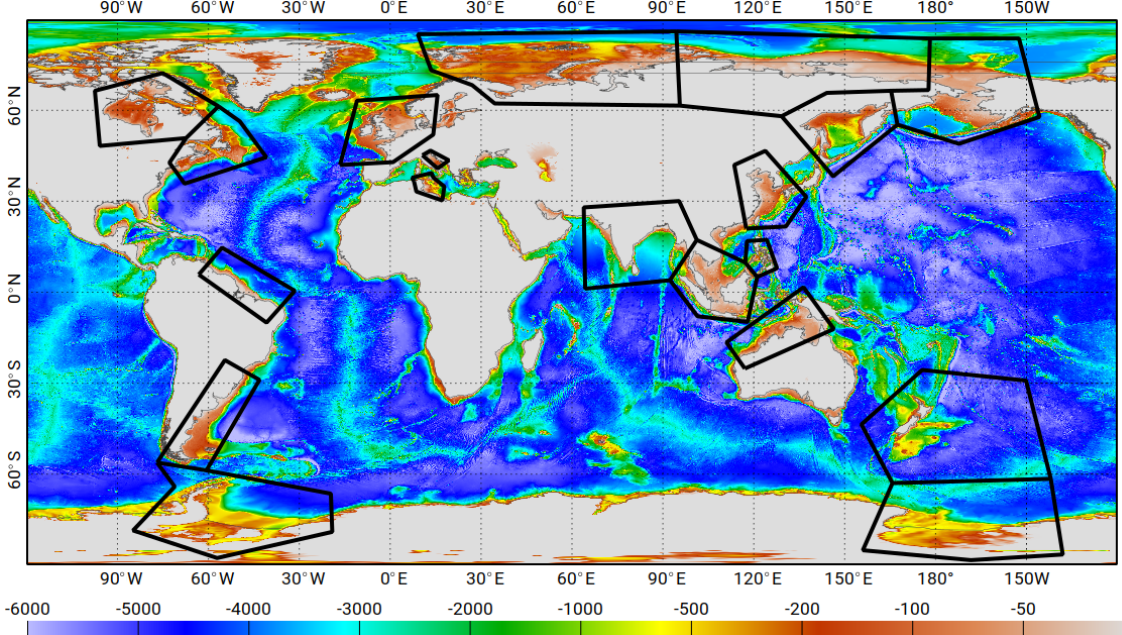
Figure 8. Bathymetry (in metres) used as input in the FES2014 hydrodynamic simulation and polygons where the bathymetry perturbations were implemented for the bathymetry ensemble (note that the members related to the perturbation of bathymetry in the Weddell Sea have been discarded from the final data assimilation ensemble; see the data assimilation section for